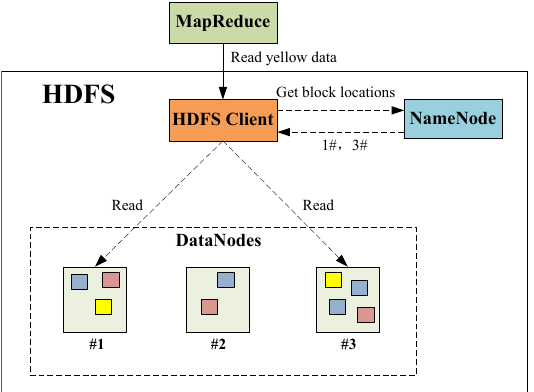
Figure 3. Hadoop Distributed File System (HDFS) structure and its reading process.